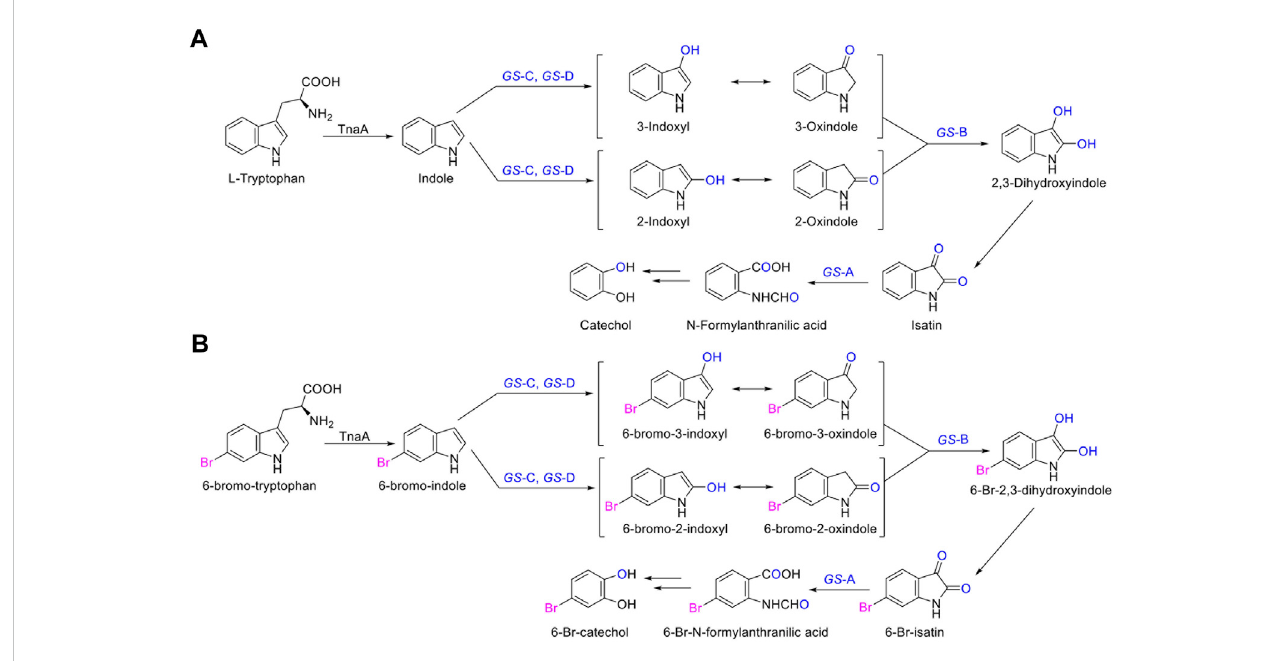
FIGURE 10 (A,B) Scheme of the indole biodegradation gene clusters assisted selective synthesis of Tyrian purple.